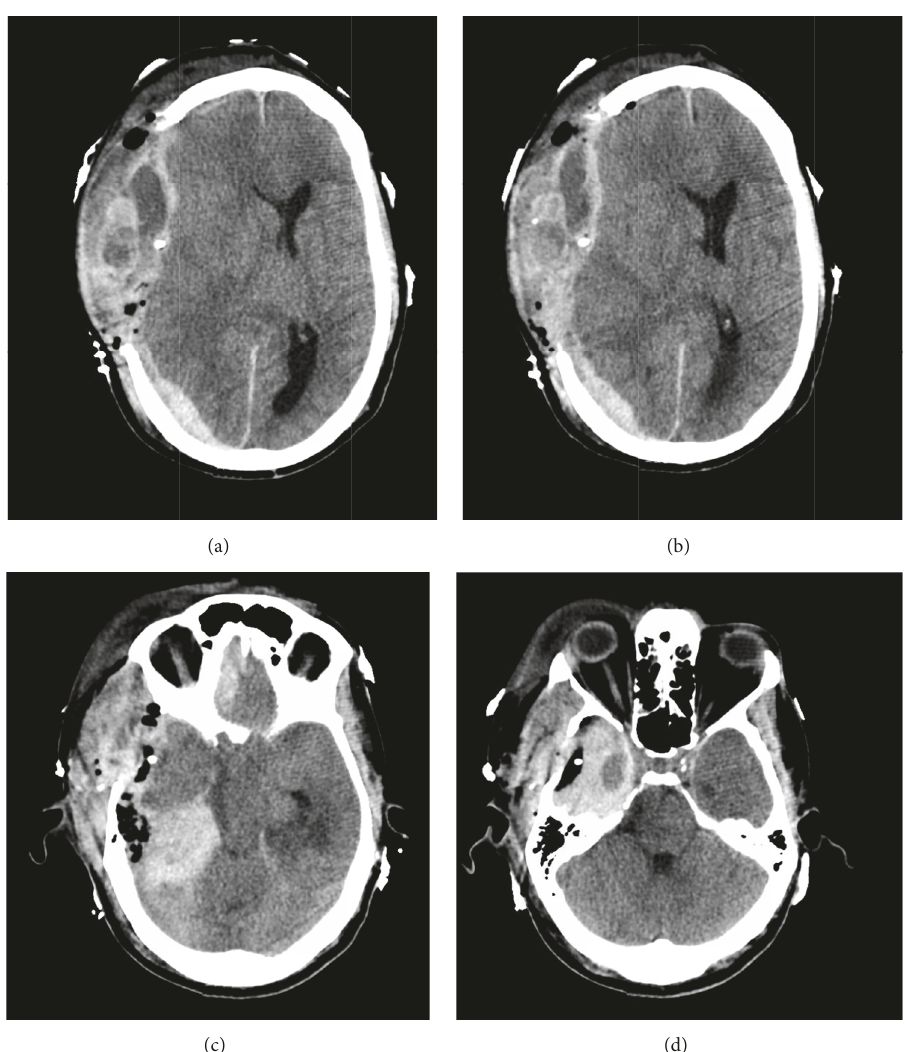
Figure 4: Repeat CT 6 hours after first surgery showing reappearance of mixed density mass along the right convexity with again persistent midline shift ((a) and (b)). There is reherniation with loss of right temporal horn and basilar cisterns once again (c). Of note, the imaging characteristics of the small subtemporal hematoma are unchanged (d), speaking to the differing contents of the panhemispheric subdural density (versus hematoma) seen in panels (a) and